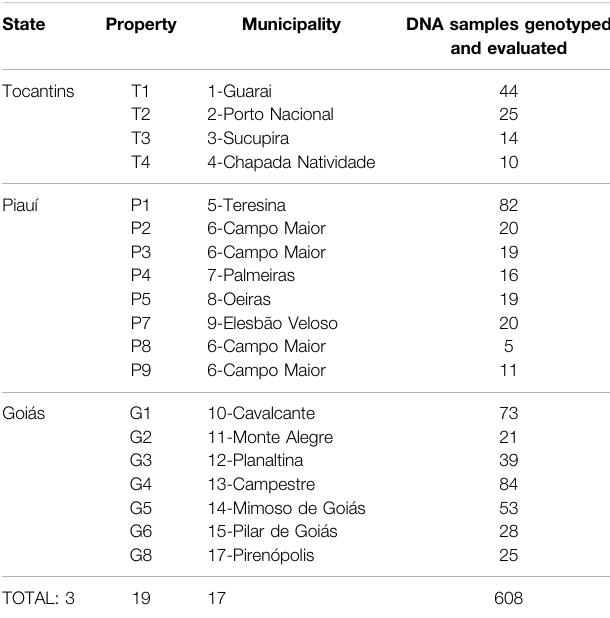
TABLE 2 | Collection state, sampled properties, city, number of DNA samples processed, and fi nal number of samples analyzed after fi ltering of genotypic data.